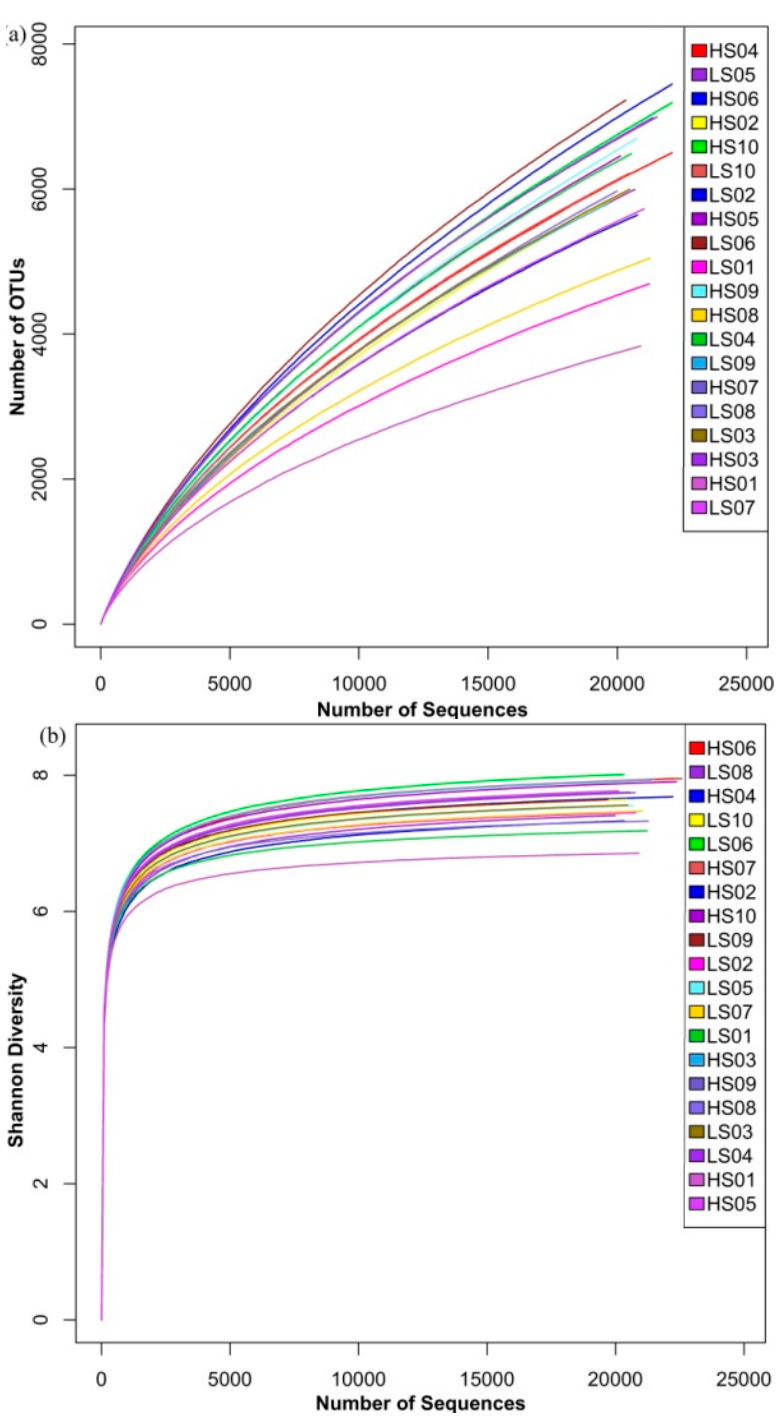
Figure 2. Rarefaction curves for ( a ) OTU (Operational taxonomic units); and ( b ) Shannon index were calculated using MOTHUR with reads for each sample using 0.03 distance OTUs.